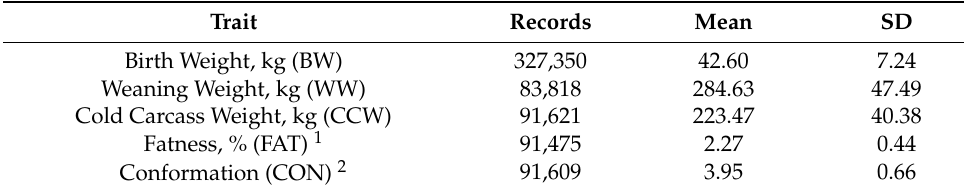
Table 1. Number of records, phenotypic means, and standard deviation of growth and carcass quality